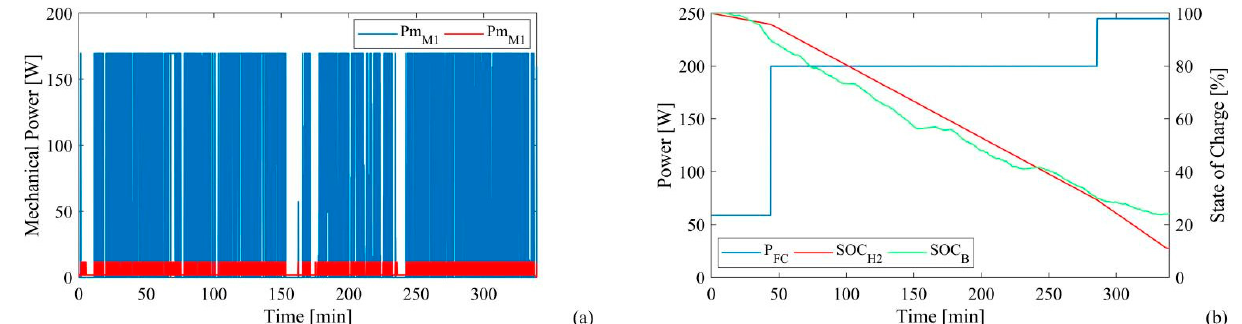
Figure 11. AMV performance in Journey 3: ( a ) Motor mechanical power trends; ( b ) Fuel cell power, hydrogen tank and battery state of charge trends.